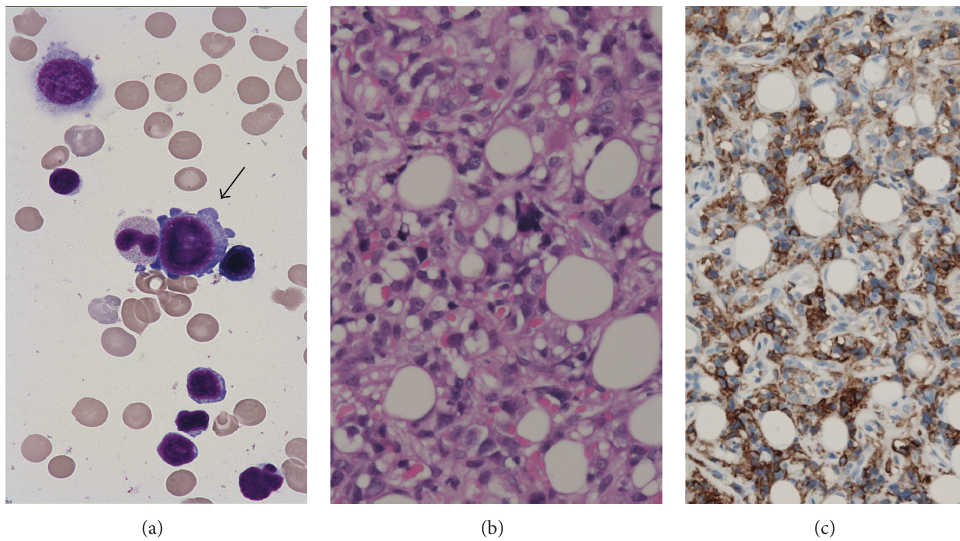
Figure 2: (a) Leukemic cells in the bone marrow aspirate (light-Giemsa staining). (b) A section of a biopsy specimen of the skin nodule (hematoxylin and eosin staining). (c) Immunostaining of the biopsy specimen of the skin nodule by using anti-CD42b